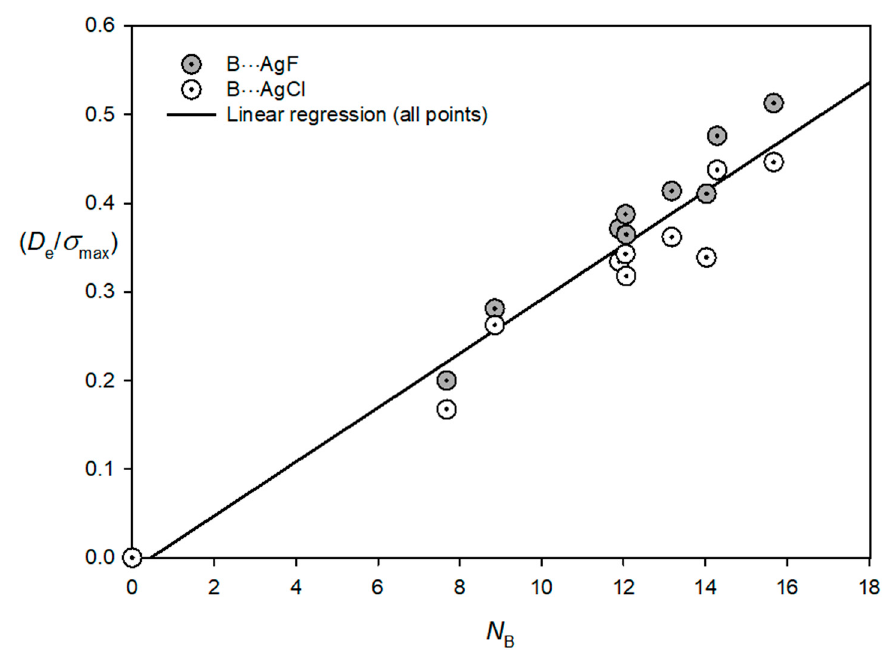
Figure 6. Normalised D e values ( D e / σ max ) plotted against the nucleophilicities of the Lewis bases B for 18 complexes B · · · AgX (X = F and Cl). The straight line is the linear regression fit to all 18 points and has the equation ( D e / σ max ) = [3.05(17) (cid:3400) 10 − 2 ] N B − 0.014(21), with R 2 = 0.9441.